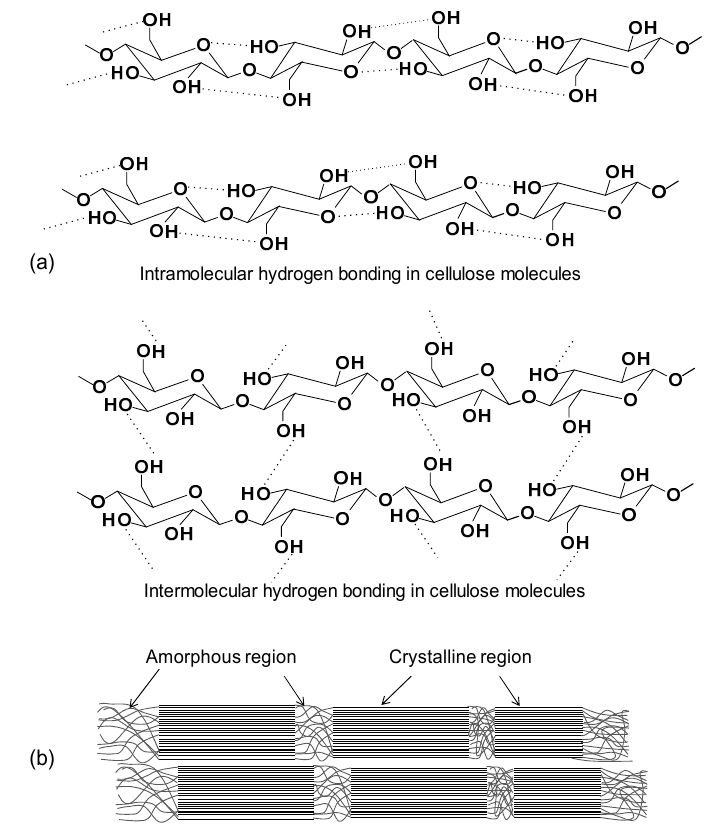
Figure 3. ( a ) Intra- and inter-molecular hydrogen bonding and ( b ) amorphous and crystalline region in cellulose molecules [11].